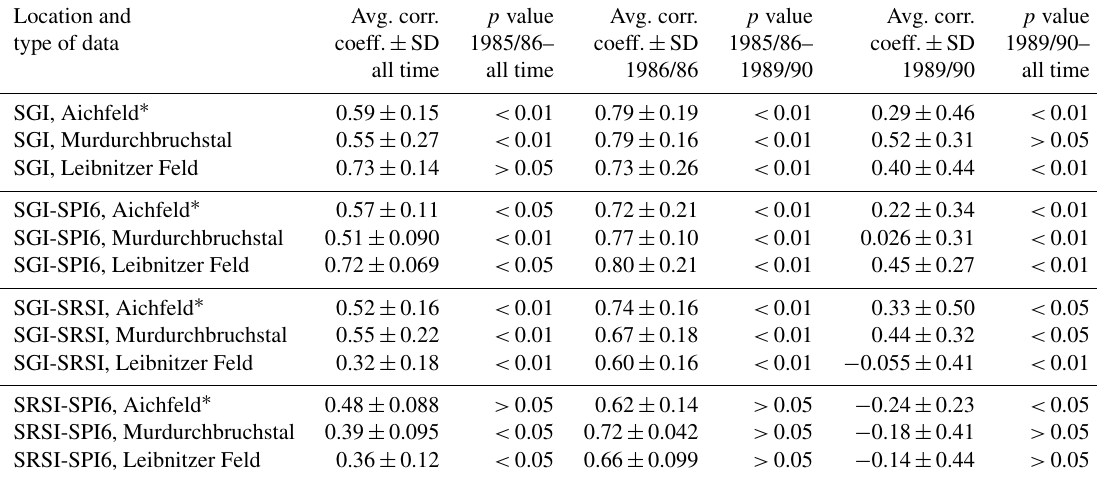
Table 4. Average Pearson correlation coefficients of a subregion for SGI time series with each other, SGI time series with the SPI6 and SGI time series with SRSI with their standard deviations for each subregion for the complete time series, during snow-rich (1985/86) and snow-poor (1989/90) conditions. Also shown is the p value indicating the statistical significance of the difference between the correlation coefficients between the full time period, snow-rich and snow-poor conditions. Location and Avg. corr. p value